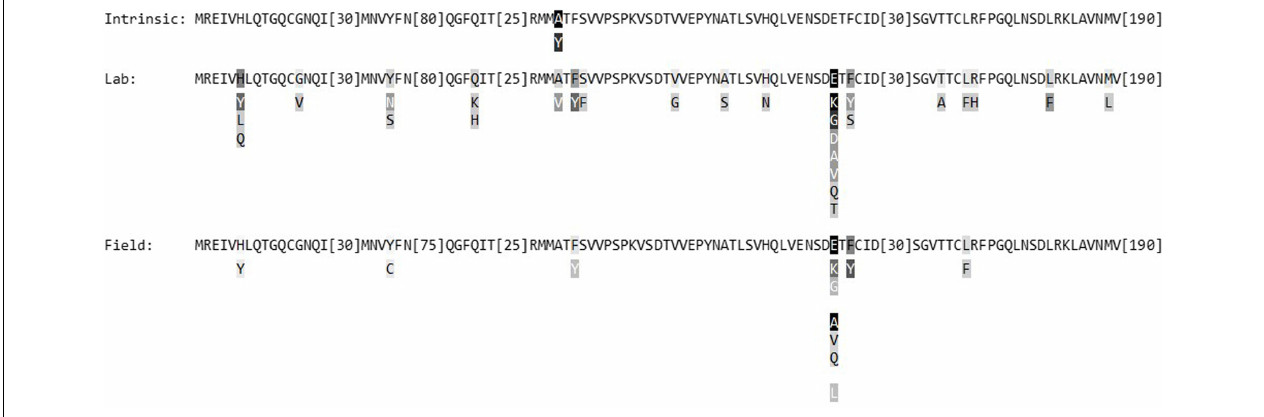
FIGURE 1 | Summary of key β -tubulin amino acid substitutions in intrinsically resistant fungal species, and resistant laboratory mutants and field isolates of other fungal species. Top lines: wild-type consensus sequence; darker shading indicates residues at which substitutions occur in more species. Square brackets: omitted residues (no substitutions). Letters under sequences: substituting amino acids in resistant mutants/isolates; darker shading indicates substitutions occurring in more